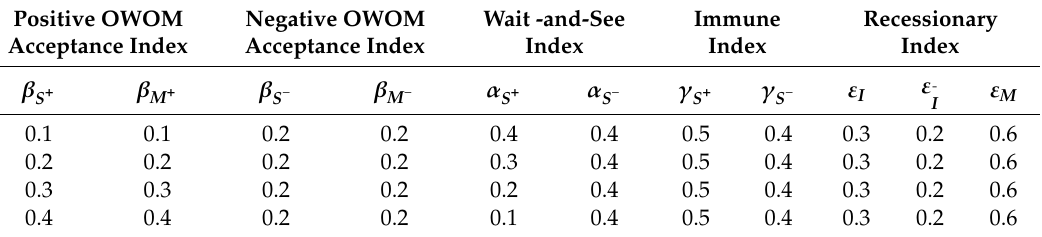
Table 4. Simulation Experiment 1 parameter